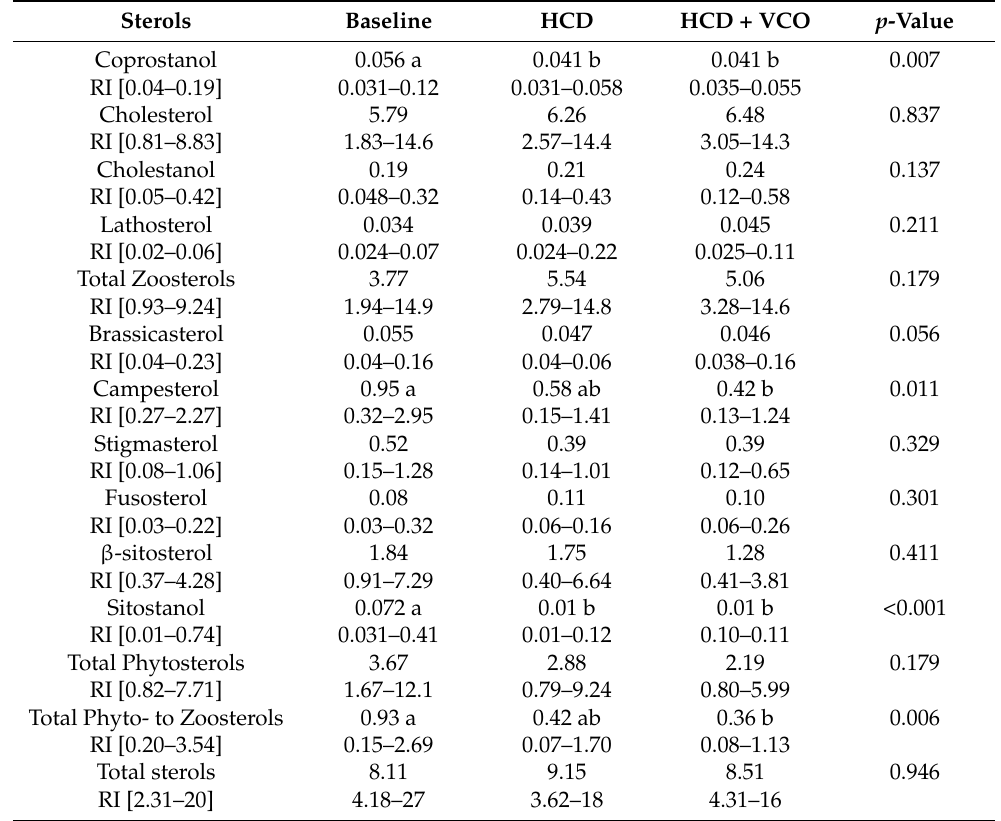
Table 5. Concentrations of sterols ( µ g/mg of dry feces) in canine fecal samples dogs during the first visit (baseline), after receiving a home-cooked diet for 7 days (HCD), and after supplementation with virgin coconut oil (HCD + VCO). Data are expressed as median and